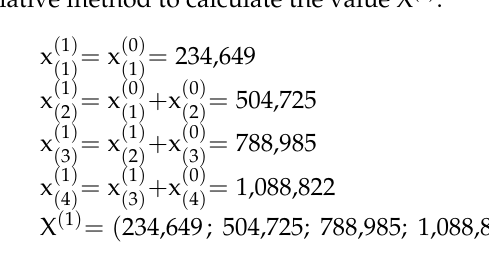
Figure 6. Observed groups’ predicted probabilities.